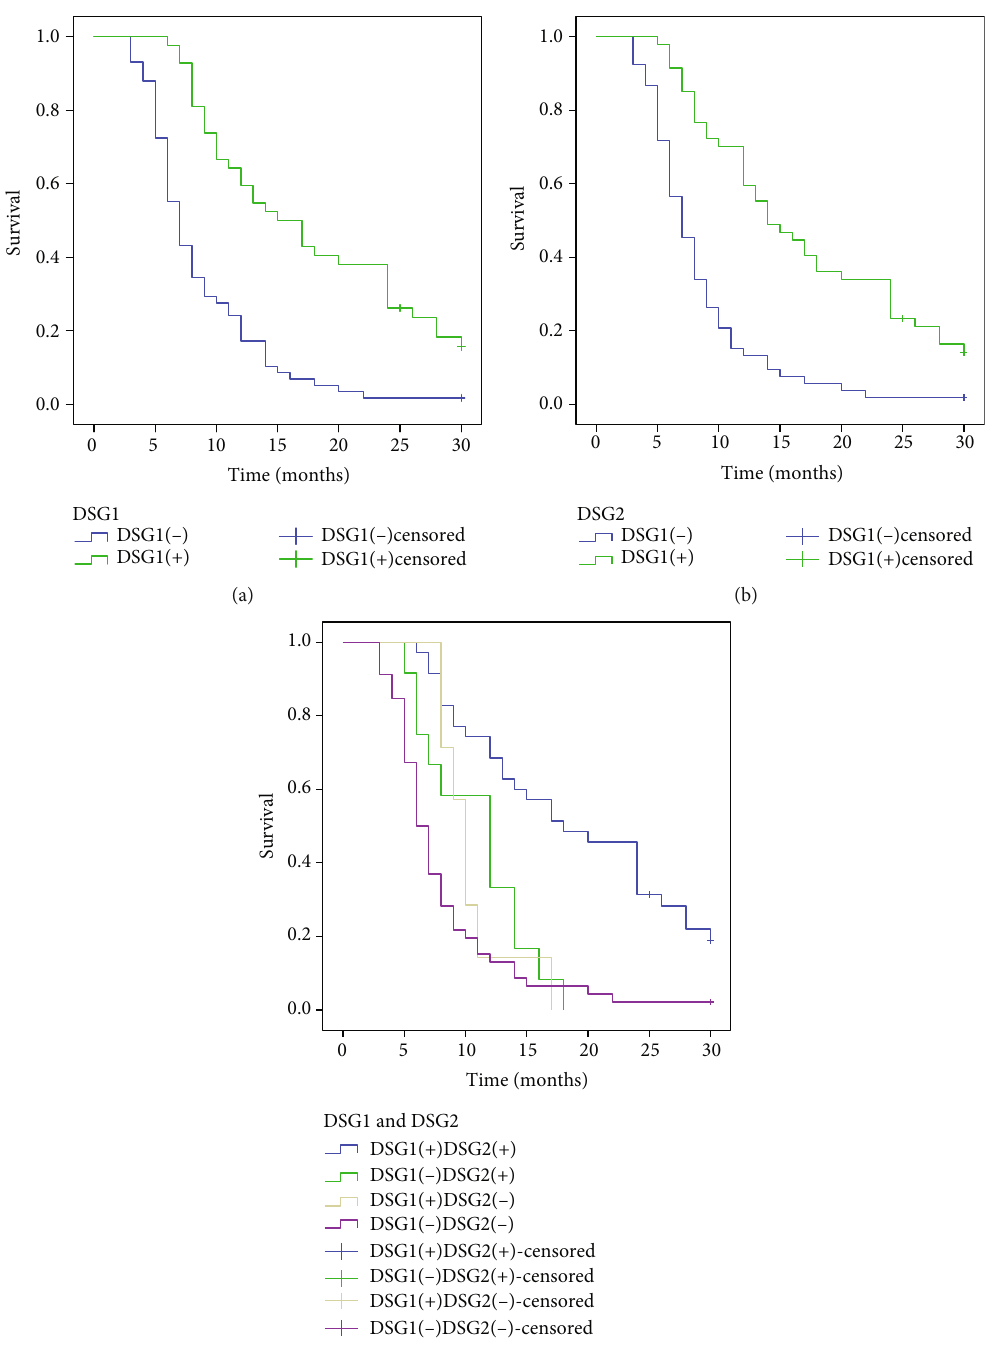
Figure 3: Kaplan-Meier curves for EHCC. (a) Positive and negative expression of DSG1 in EHCC. (b) Positive and negative expression of DSG2 in EHCC. (c) DSG1 and DSG2 expression in